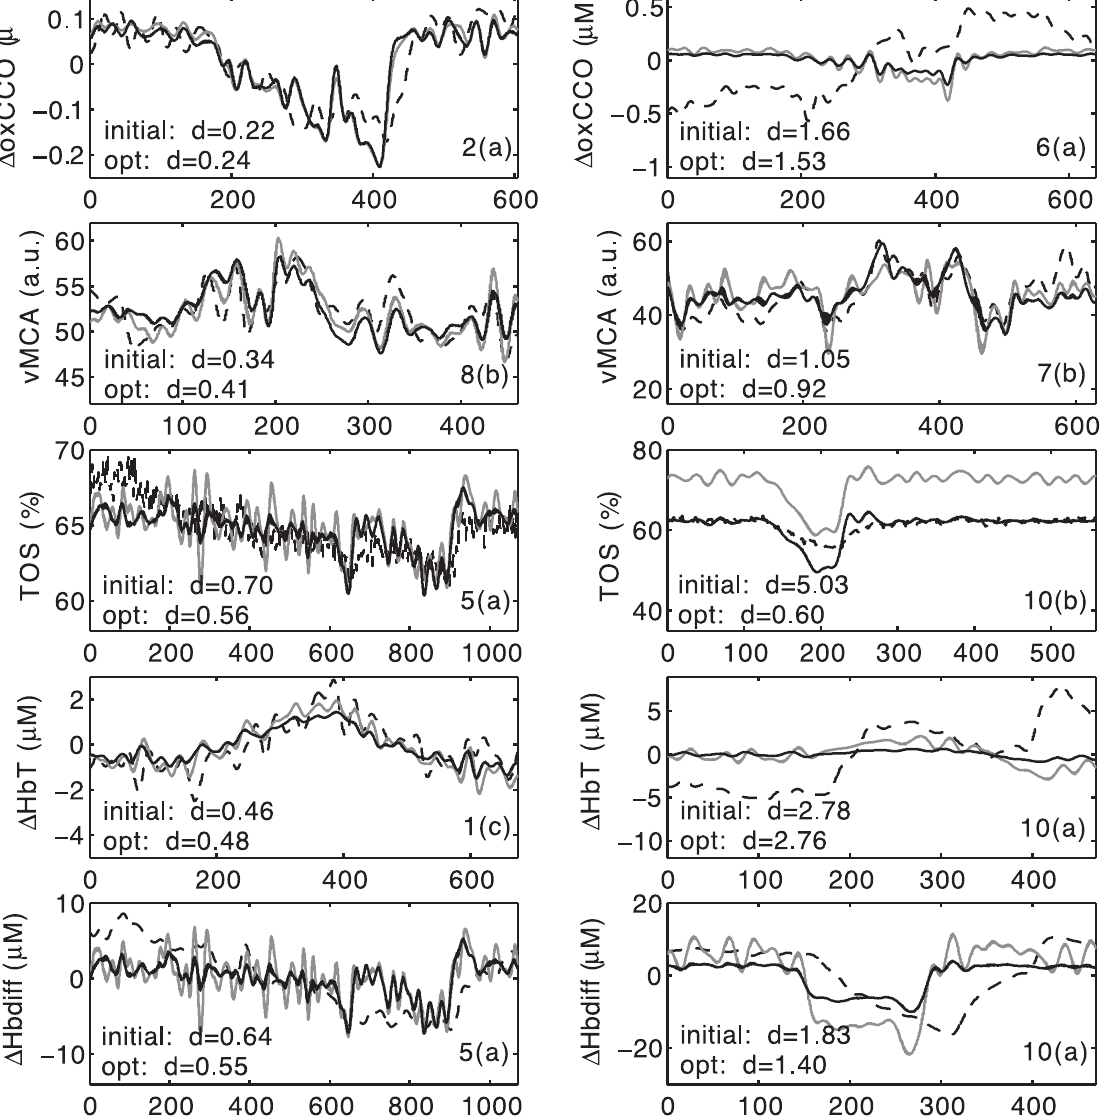
Figure 4. Best and worst performance of the unoptimised model and optimisation results for each signal. Bold lines are the model output post optimisation, grey lines are the unoptimised model output, while the dashed lines are measured data. The best fit prior to optimisation is on the left, while the worst fit is on the right. The weighted distances d are on the bottom left of each plot, while the subject and challenge are on the bottom right (e.g., ‘‘2(a)’’ means ‘‘Subject 2, first